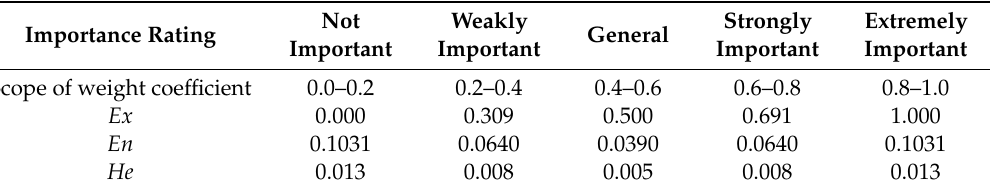
Table 2. Linguistic scale of hazard